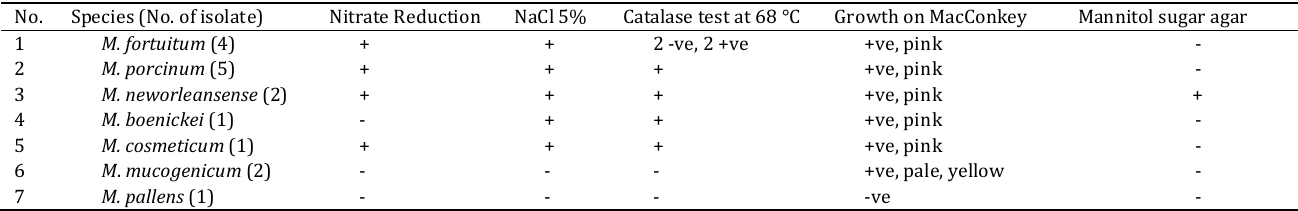
Table 2. Biochemical tests result of the nontuberculous mycobacteria (NTM) spp No. Species (No. of isolate)